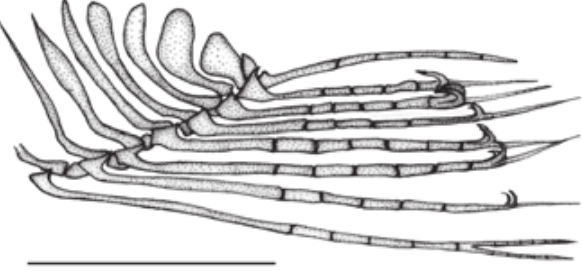
Fig. 4. Tyttocharax metae , paratype, IUQ 2343, adult male, 18.4 mm SL. Posterior eight anal-fin rays and supporting pterygiophores left lateral view. Posterior ray split to its base with anterior half bearing bony hooks. Scale bar = 1